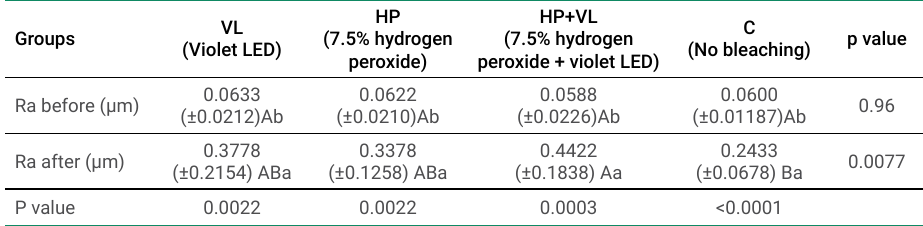
Table 1. Mean (±SD) of Ra values (μm) of the specimens that were stained and later received bleaching treatments